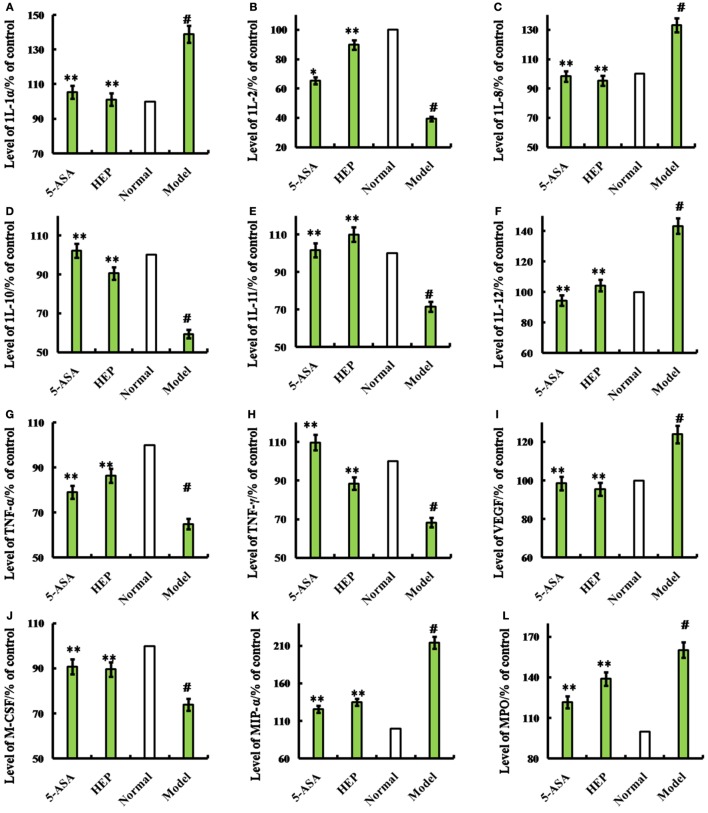
Effects of HEP on trinitrobenzenesulfonic acid solution (TNBS)-induced rats. Normal group; model group, induced by TNBS enema; HEP group, the crude protein extract-treated group after TNBS enema; and positive control group, treated with 100 mg/(kg ⋅ day) of 5-aminosalicylic acid after TNBS enema. After treatment for 14 days, cytokines interleukin (1L)-1α (A), 1L-2 (B), 1L-8 (C), 1L-10 (D), 1L-11 (E), IL-12 (F), tumor necrosis factor (TNF)-γ (H), TNF-α (G), vascular endothelial growth factor (VEGF) (I), MIP-α (J), macrophage colony-stimulating factor (M-CSF) (K), and myeloperoxidase (MPO) (L) were produced. The assays were carried out according to the procedures recommended in the enzyme-linked immunosorbent assay kit manual. Values were means ± SDs of three independent experiments. #P < 0.05 vs the normal group, *P < 0.05, **P < 0.01 vs the TNBS-treated group.